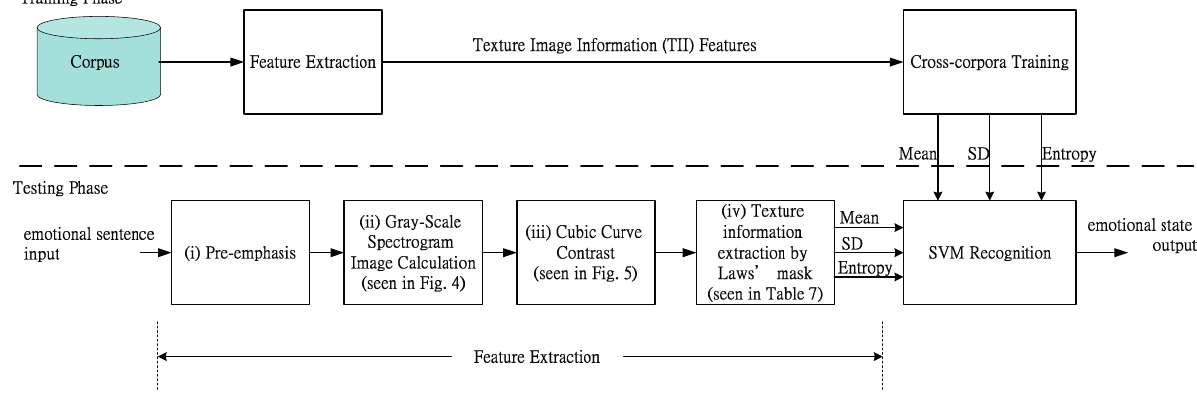
Figure 1. Diagram of the proposed TII-based ESS